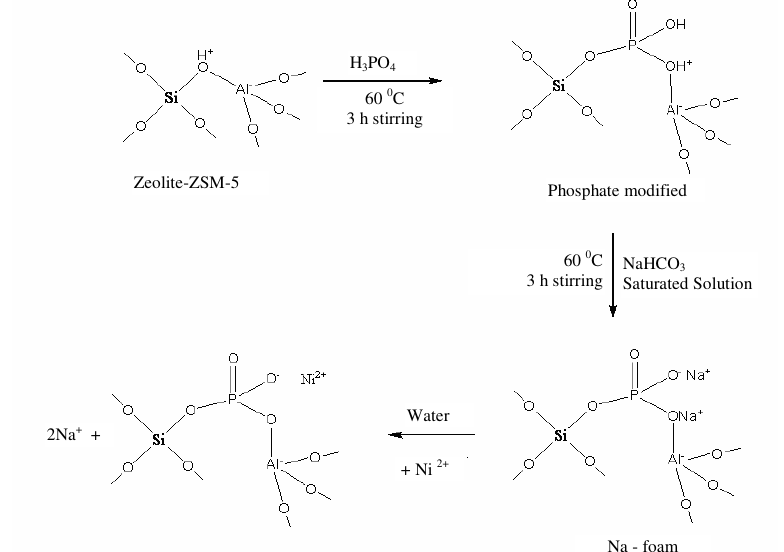
Figure 1 . Reaction schemes illustrating modification of PNa